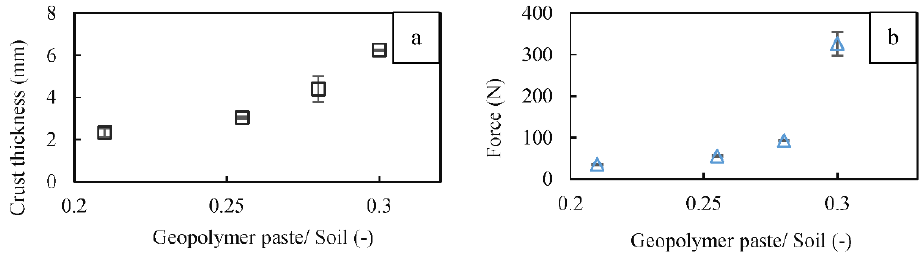
Figure 8. Variations in ( a ) crust thickness and ( b ) penetration failure force for FS30-treated samples with different geopolymer/soil ratios.